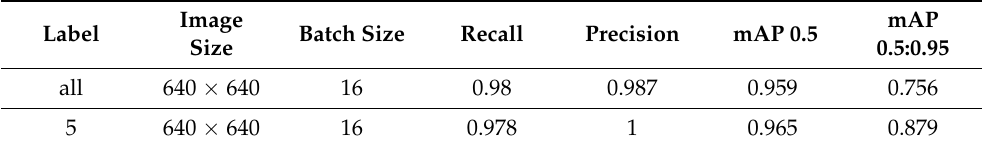
Figure 6. Performance evaluation of YOLOv5 on NVIDIA Jetson Nano. Table 1. Yolov5 training